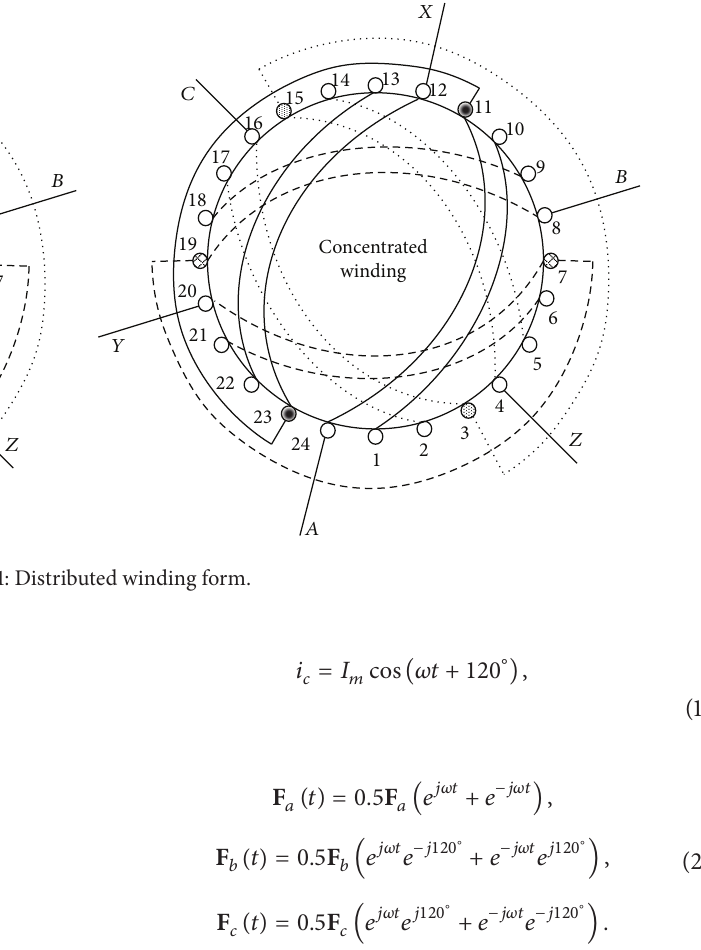
Figure 1: Distributed winding form.